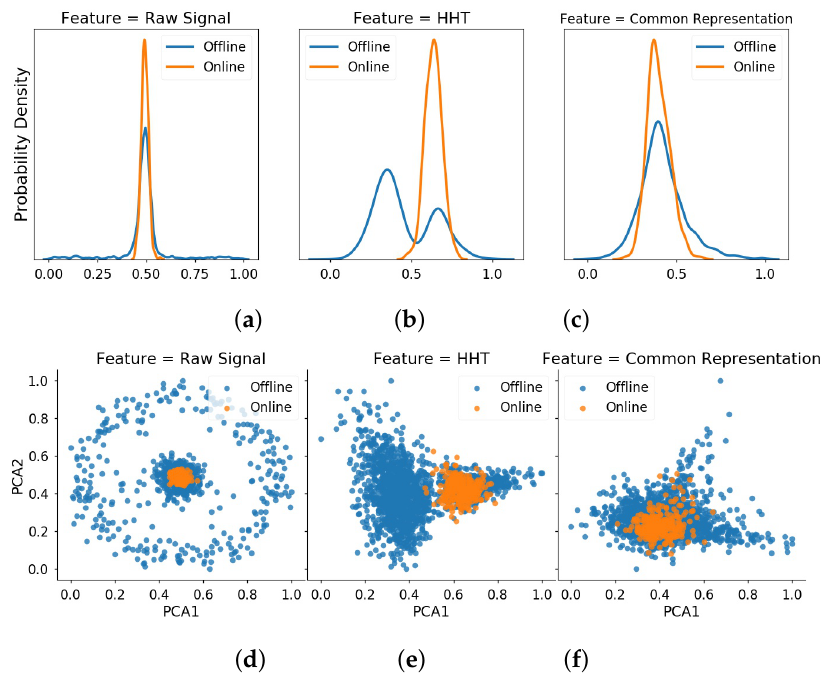
Figure 18. Comparative distribution of Target 1 and six training bearings, with ( a – c ) the probability density distribution of raw time signal, HHT marginal spectrum, the common deep features by domain adaptation DAE, and ( d – f ) the feature distribution corresponding to ( a – c ), respectively.